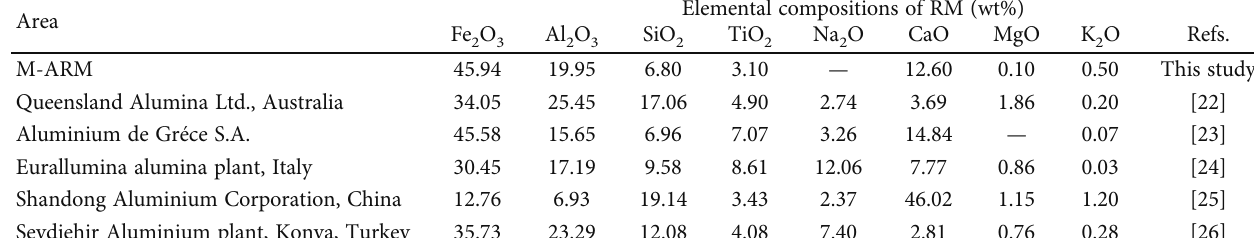
Table 2: Compare the main elemental compositions of RM from di ff erent regions.